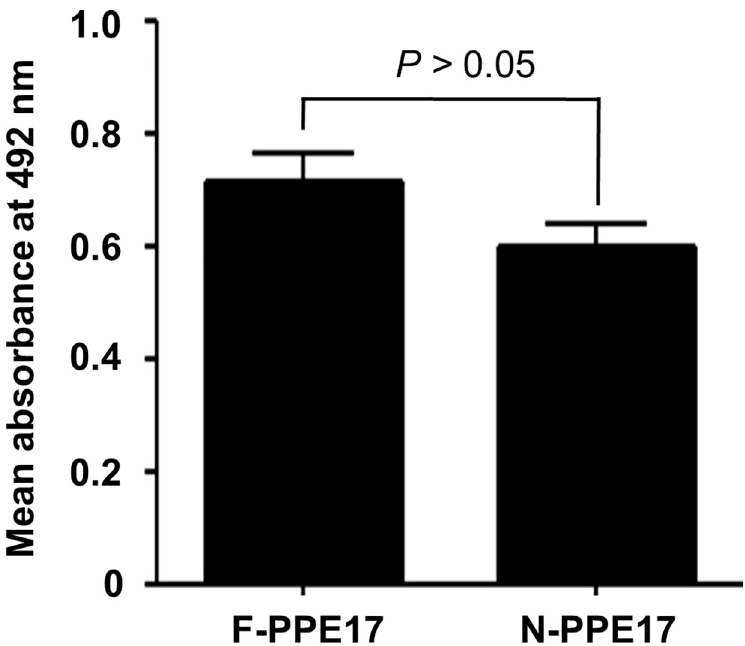
Fig 4. Both full-length PPE17 (F-PPE17) and N-terminal domain of PPE17 (N-PPE17) proteins display higher antibody titers in LTBI individuals. The mean absorbance values (OD 492 ) of LTBI individuals were compared for F-PPE17 and N-PPE17 proteins following